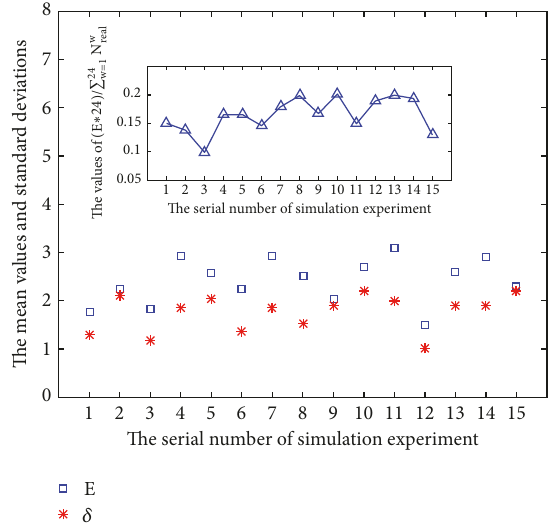
Figure 18: The values E and 𝛿 of |𝑁 𝑤 𝑟𝑒𝑎𝑙 − 𝑁 𝑤 𝑠𝑖𝑚𝑢𝑙𝑎𝑡𝑖𝑜𝑛 | at 24 waiting areas during the off-peak time